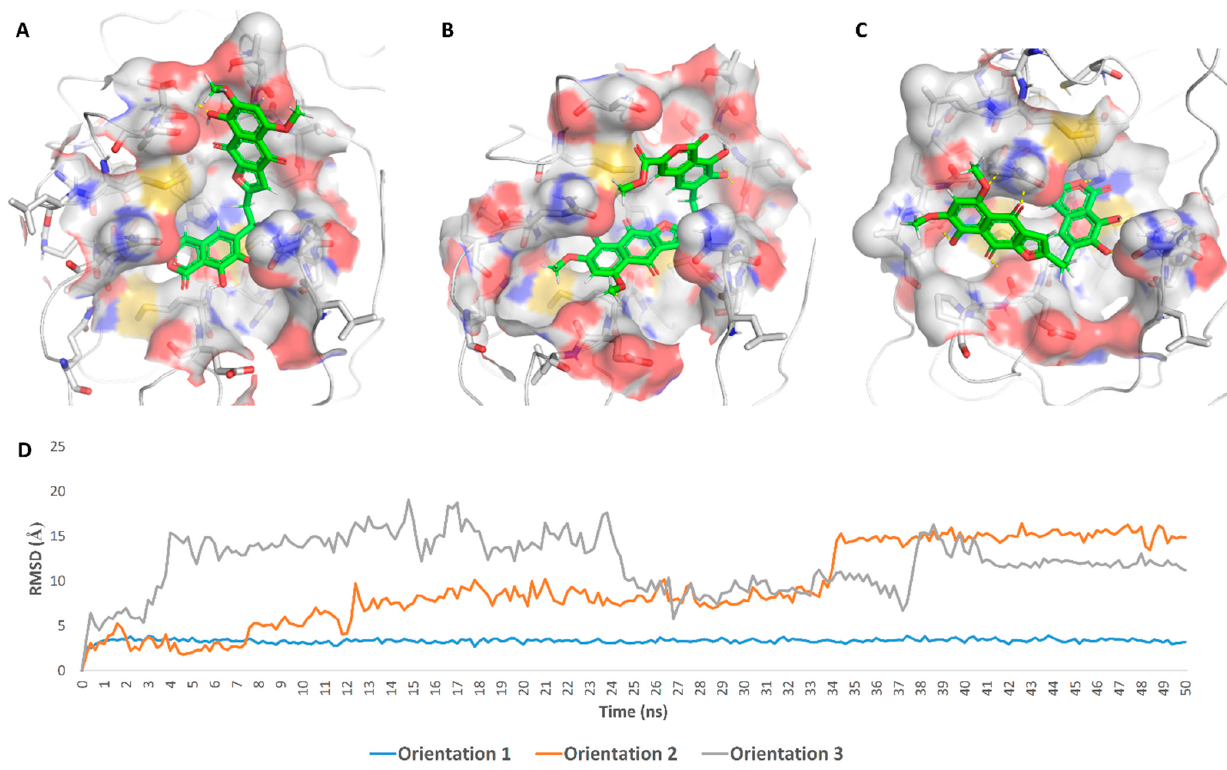
Figure 3. Binding orientations of α -rubromycin inside the M Pro active site (orientations 1–3, A – C respectively), and their average RMSDs over 50 ns of MDS ( D ).